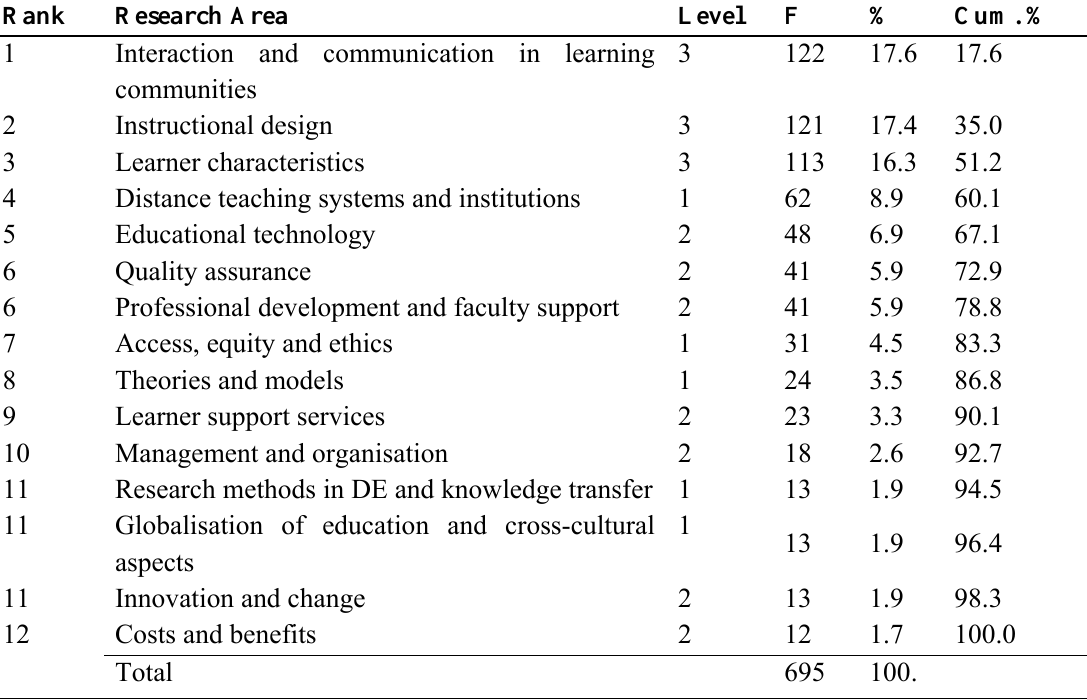
Ranking of Research Areas by Number of Articles by Research Area (N = 695) Rank Research Area Level F % Cum.